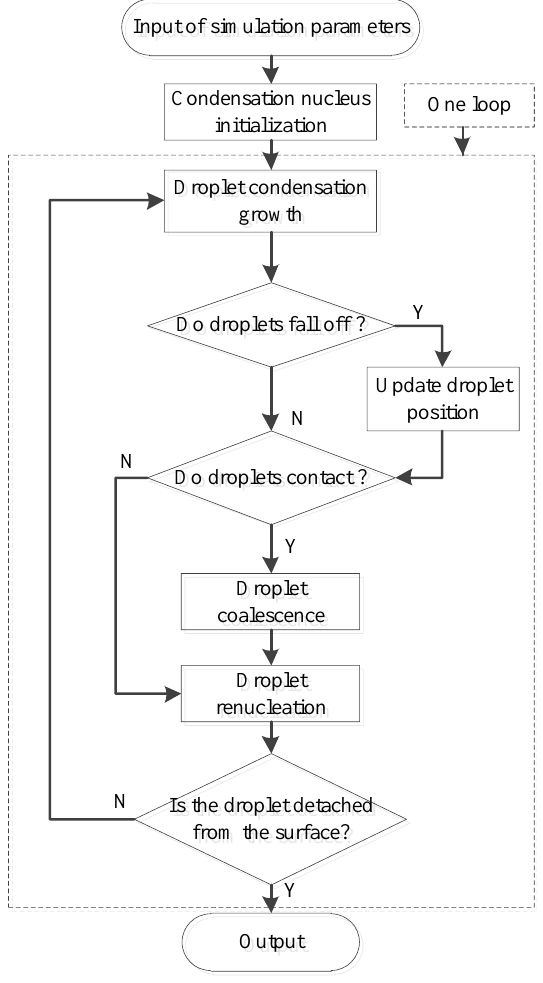
Figure 5. Flow chart of the simulation procedure.